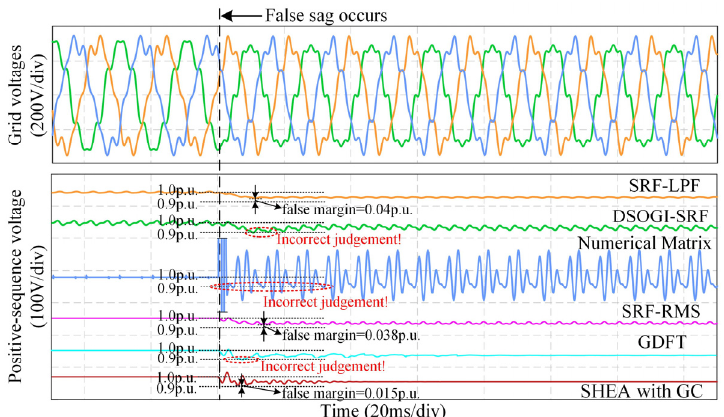
Figure 13. The results of different voltage detection methods in case of shallow sag